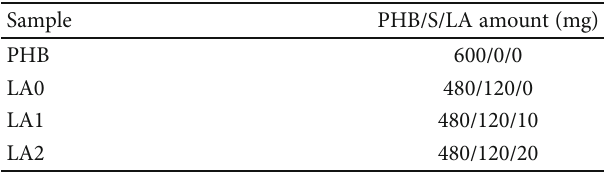
Table 1: PHB/S/LA composite fi lm preparation